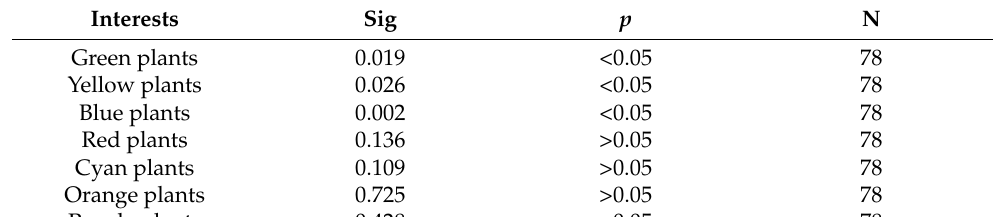
Table 3. Statistical results of the correlation between interest and stress sentiment.